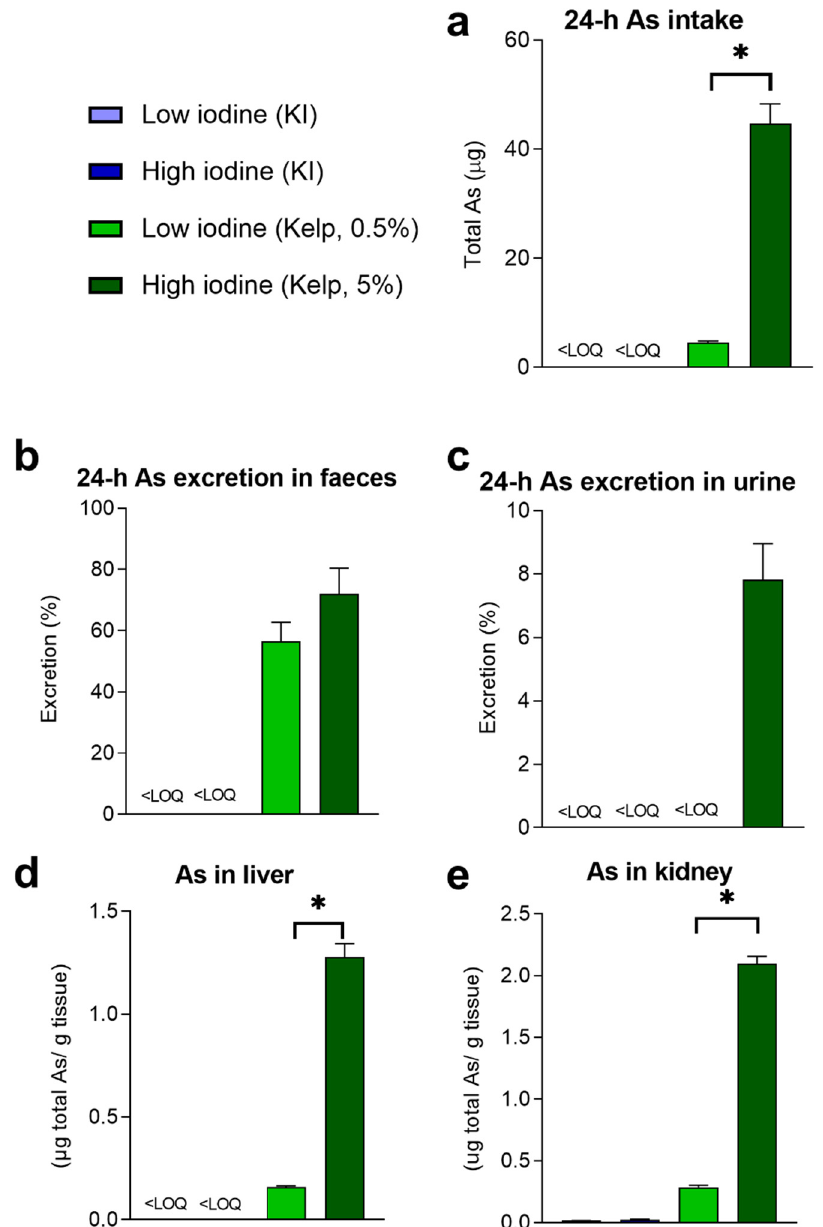
Figure 2. ( a ) 24 h total As dietary exposure and percent excretion in ( b ) faeces and ( c ) urine in rats fed KI and sugar kelp in week 10. ( d ) The accumulated concentration of total As in liver and ( e ) kidney tissue after 13 weeks of feeding. Data are shown as mean ± SEM ( n = 8–10). Measured values below the limit of quantification (LOQ) As = 0.001 (mg/kg) are marked < LOQ. Significant differences between groups fed the two levels of kelp in the diet are marked with *. Data were analysed with a standard t-test.